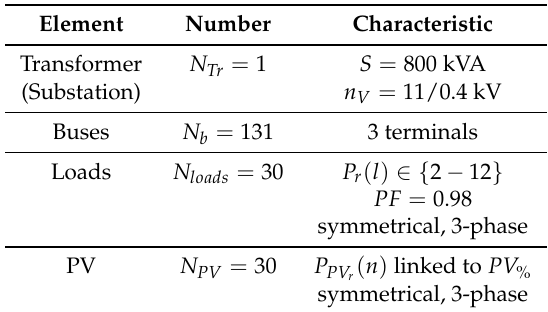
Figure 4. Graphical representation of the LV feeder under test with PV systems. Table 1. Basic grid